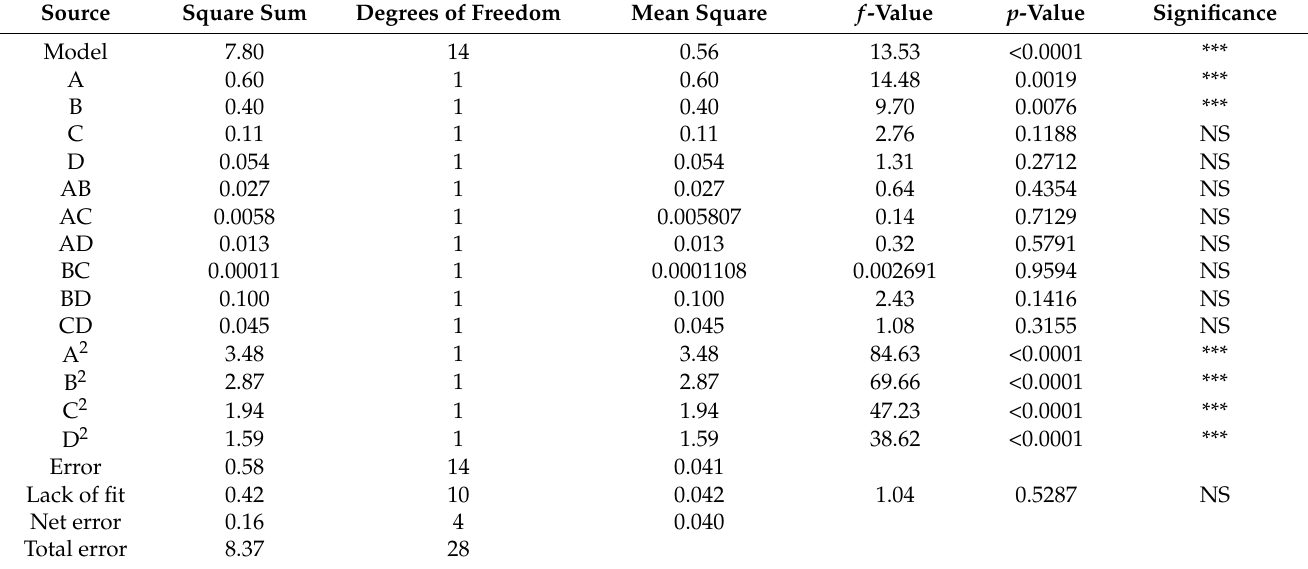
Table 3. Analysis of variance of the results obtained using Box–Behnken